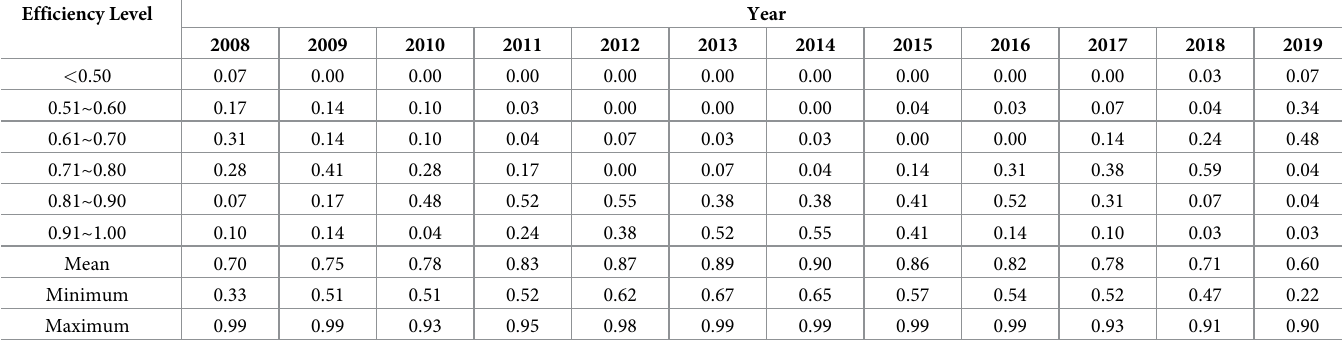
Table 8. Frequency distribution of cost efficiency estimates for sows, 2008–19. Efficiency Level